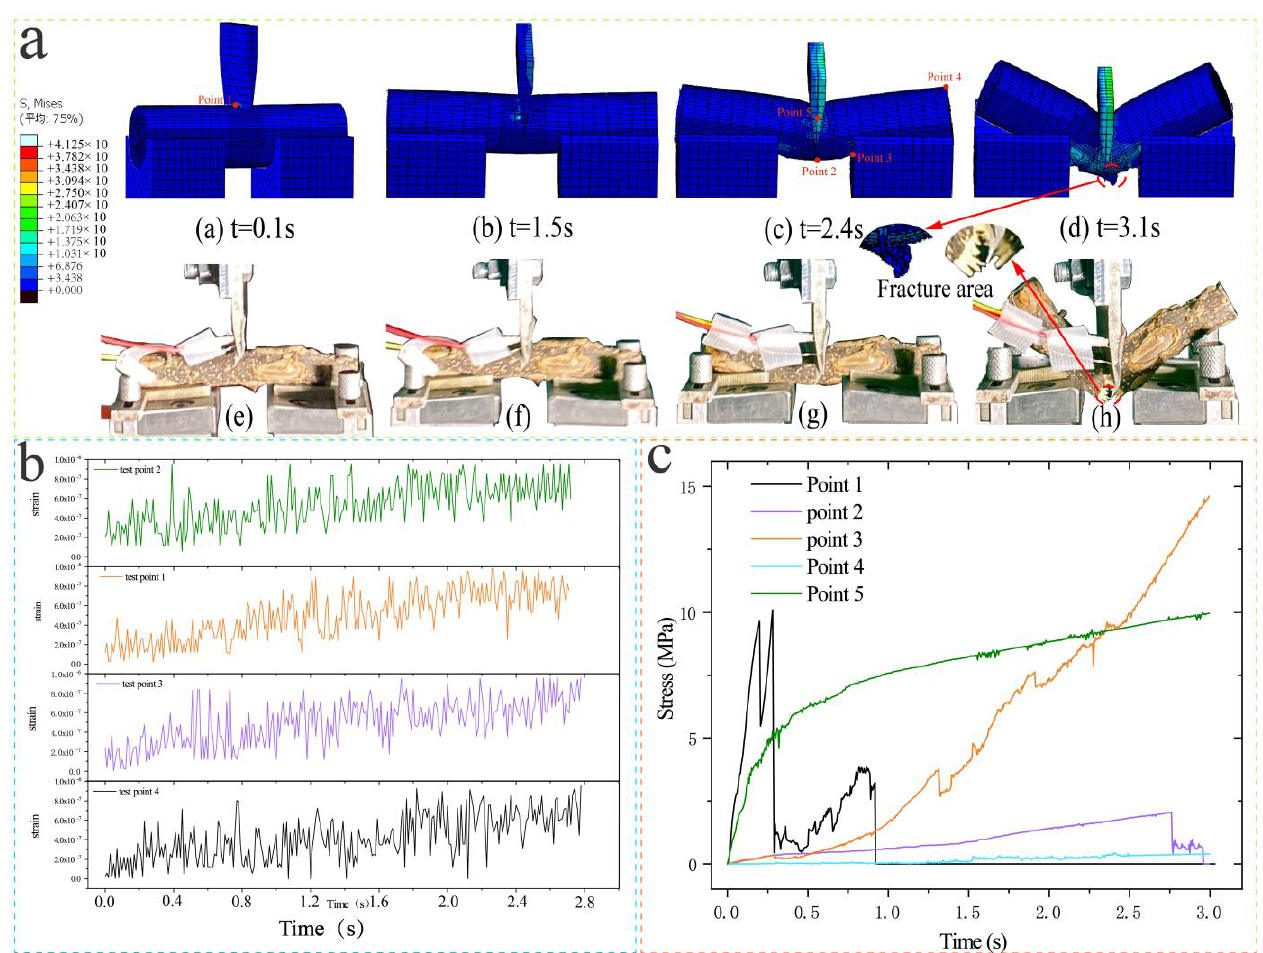
Figure 13. Cutting monitoring comparison model. ( a ) Comparison of span cut simulation and actual different time node patterns. ( b ) Strain changes in the tool during cutting. ( c ) The process of stress change in several key nodes during cutting.